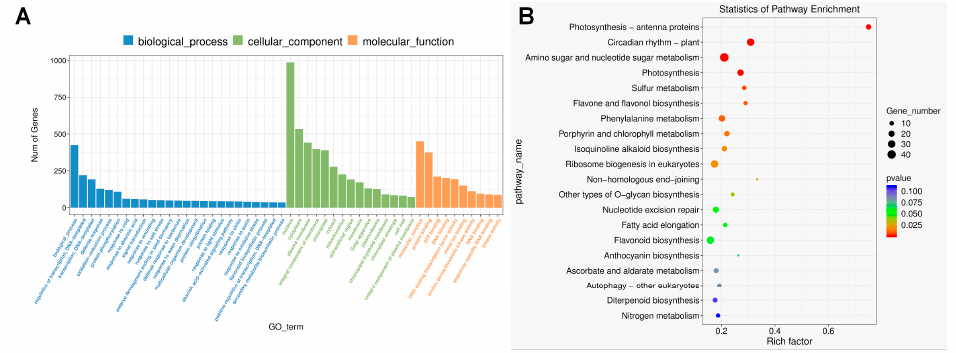
Figure 2. GO enrichment analysis ( A ) and KEGG enrichment analysis ( B ) of DEGs. The modules only illustrate the top 20 pathways showing the most pronounced enrichment.